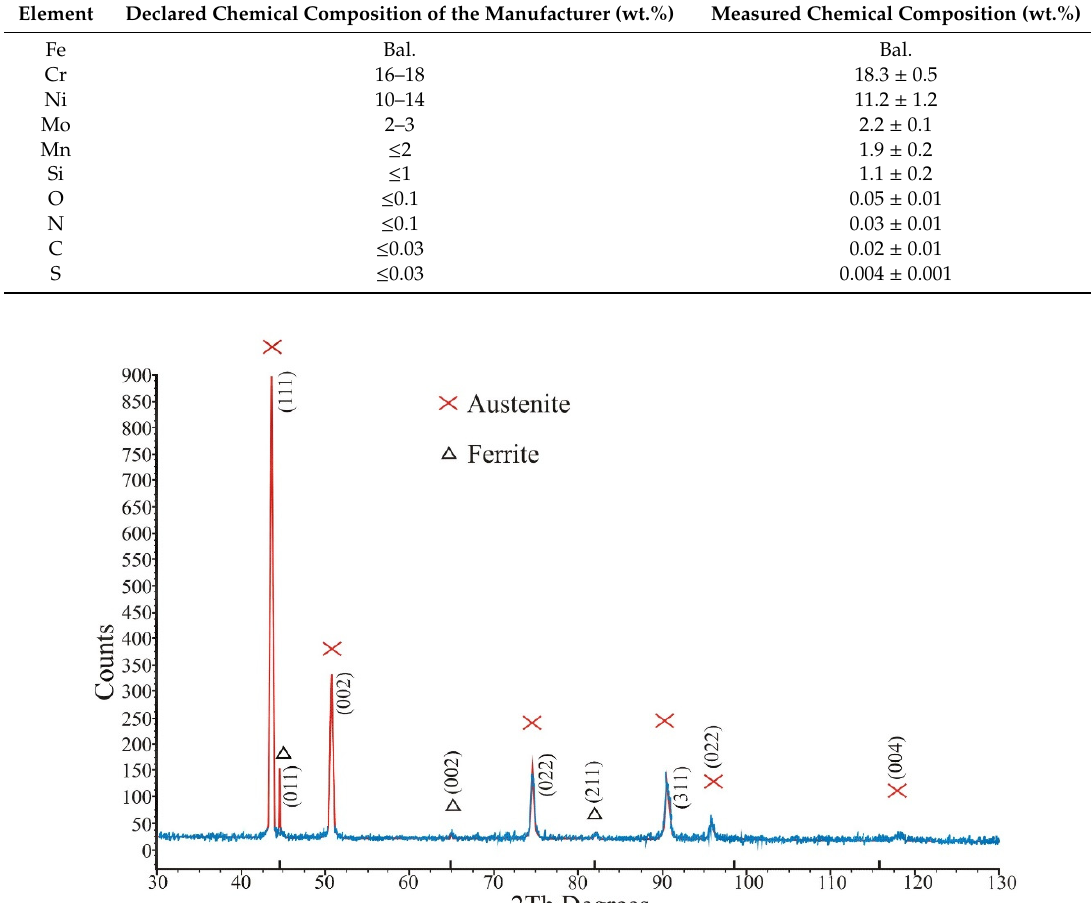
Figure 6. Particle size distribution diagram of the used 316 L powder. Table 3. Chemical composition of used powder.